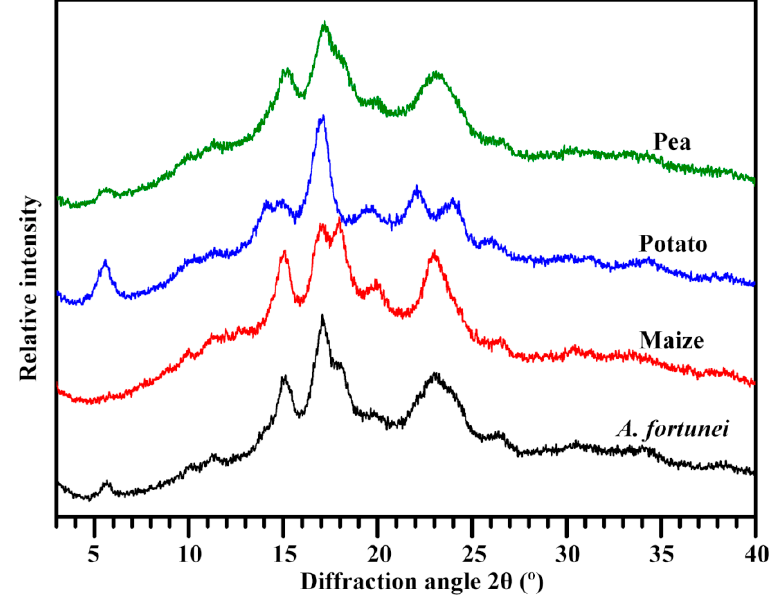
Figure 3. XRD pattern of starch.